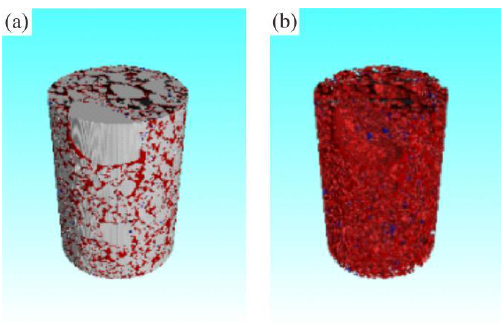
Figure 11. The spatial distribution of pores in the sample. ( a ) Pores distribution of original sample. ( b ) Pores distribution of sample after particles removal.